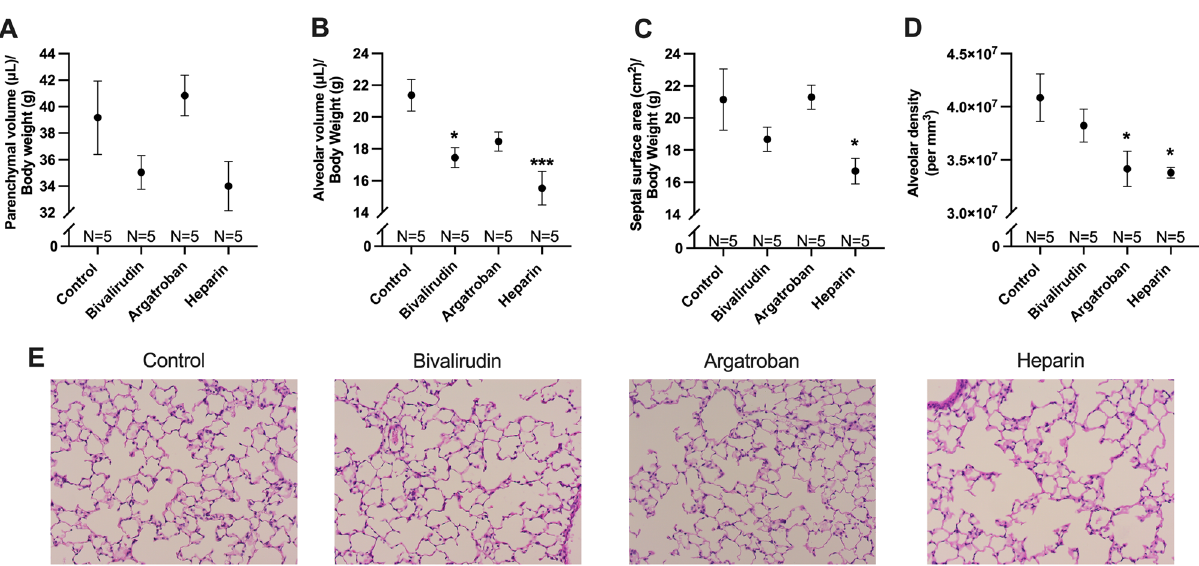
Figure 3. Lung tissue morphometric analysis. Parenchymal volume was lowest for heparin-treated mice compared to the remaining groups, although not reaching statistical significance ( A ). Alveolar volume was significantly lower in the heparin group compared to controls ( B ). Bivalirudin-treated mice also demonstrated lower alveolar volume. Septal surface area, which represents the area available for gas exchange, was significantly lower in heparin mice ( C ). Bivalirudin and argatroban did not significantly impact septal surface area. Alveolar density was significantly lower in the heparin and argatroban groups compared to controls ( D ). Bivalirudin did not significantly change alveolar density. Representative micrographs of hematoxylin and eosin-stained lung sections at 200 × magnification ( E ) demonstrate the decrease in alveolarization in heparin-treated mice compared to the control, bivalirudin, and argatroban groups. Statistical analysis of the experimental groups was done using analysis of variance (ANOVA), with Dunnett’s adjustment for multiple comparisons. Shown are mean ± standard error. *P < 0.05; *** P < fication for pulmonary morphometric analysis (Fig. 3). There were no significant differences in parenchymal volume across the four groups (Fig. 3A), although heparin-treated mice had the lowest measurement compared to controls (34.0 ± 1.9 vs. 39.2 ± 2.8 μL/g, P = 0.19). Alveolar volume (Fig. 3B) was lower in bivalirudin-treated (17.5 ± 0.6 vs. 21.4 ± 1.0 μL/g, P = 0.01) and heparin-treated (15.5 ± 1.1 vs. 21.4 ± 1.0 μL/g, P = 0.0005) mice. Sep- tal surface area (Fig. 3C), which represents the area available for gas exchange, was lower in the heparin group compared to controls (16.7 vs. 21.2 cm 2 /g, P = 0.04). Bivalirudin and argatroban did not significantly change septal surface area ( P = 0.33, P = 1.00, respectively). Finally, alveolar density (Fig. 3D) was significantly lower in